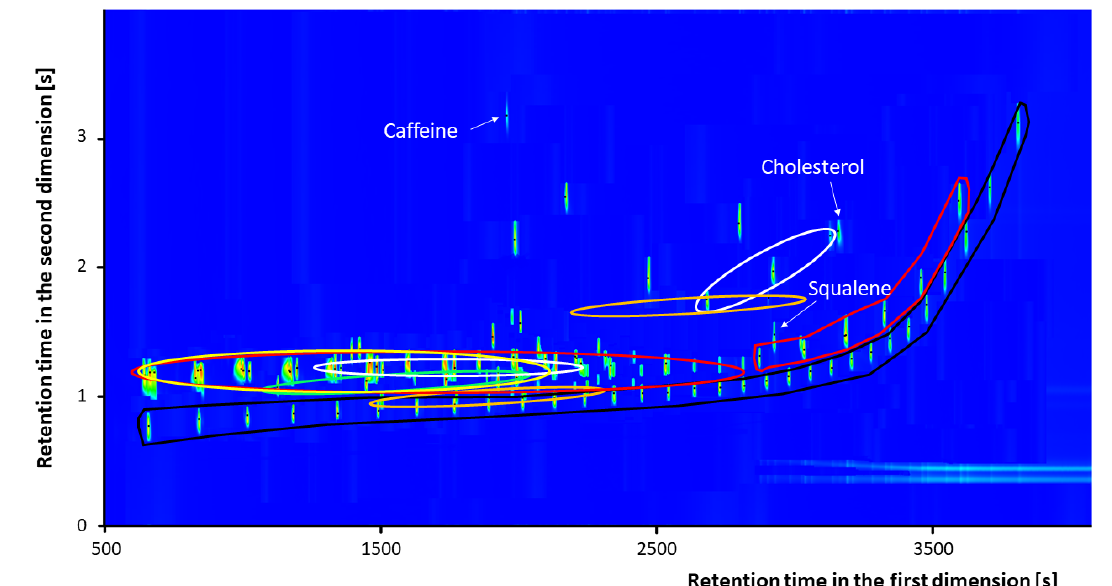
Figure 1. The TIC 2D chromatogram of the model mixture (composition see Table 1) measured under the conditions described in Section 2.4 on Rxi-5ms (2 + 30 m) and Rxi-17Sil MS (1 m) columns. The marked classification zones are the following: black ( n -alkanes), lower dark yellow (amines), upper dark yellow (amides), green (chloroalkanes), left white (alcohols), right white (ethers), yellow (aldehydes and ketones), left red (acids and esters), right red (esters of higher fatty acids), and unlabeled (others).